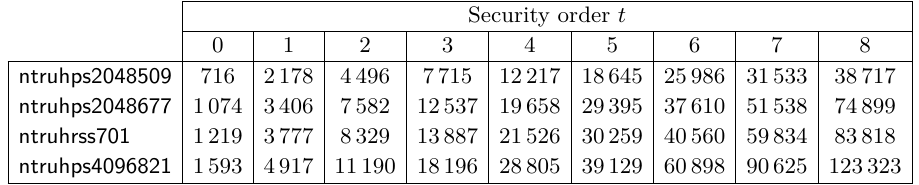
Table 5: Cycle counts for decapsulation for all parameters of NTRU , in thousands of